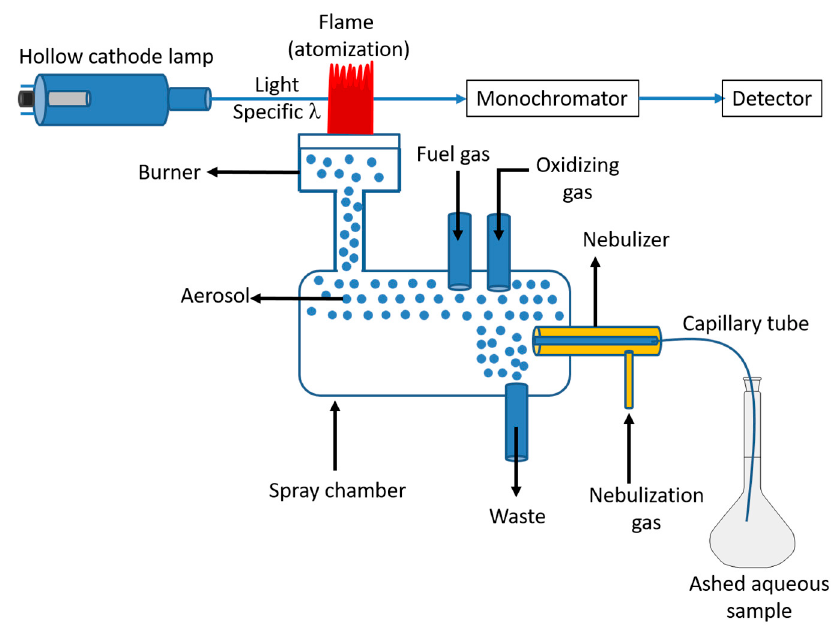
Figure 3. Flame atomic absorption spectrometry (FAAS) principle.